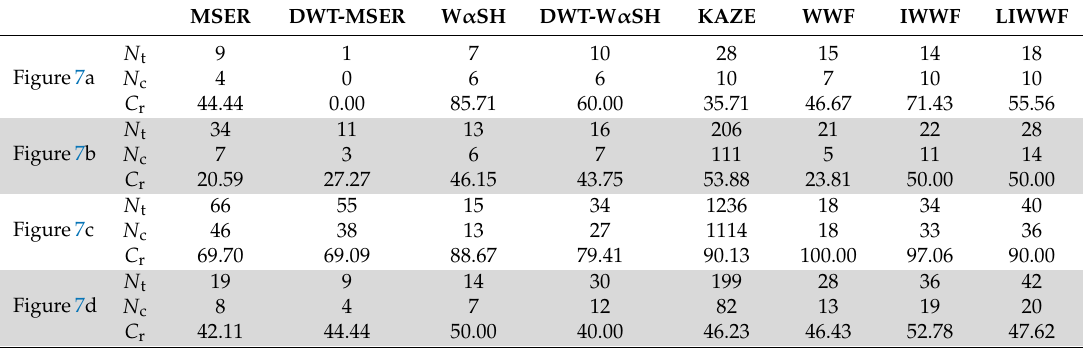
Table 2. Results of matching for stereo remote sensing image